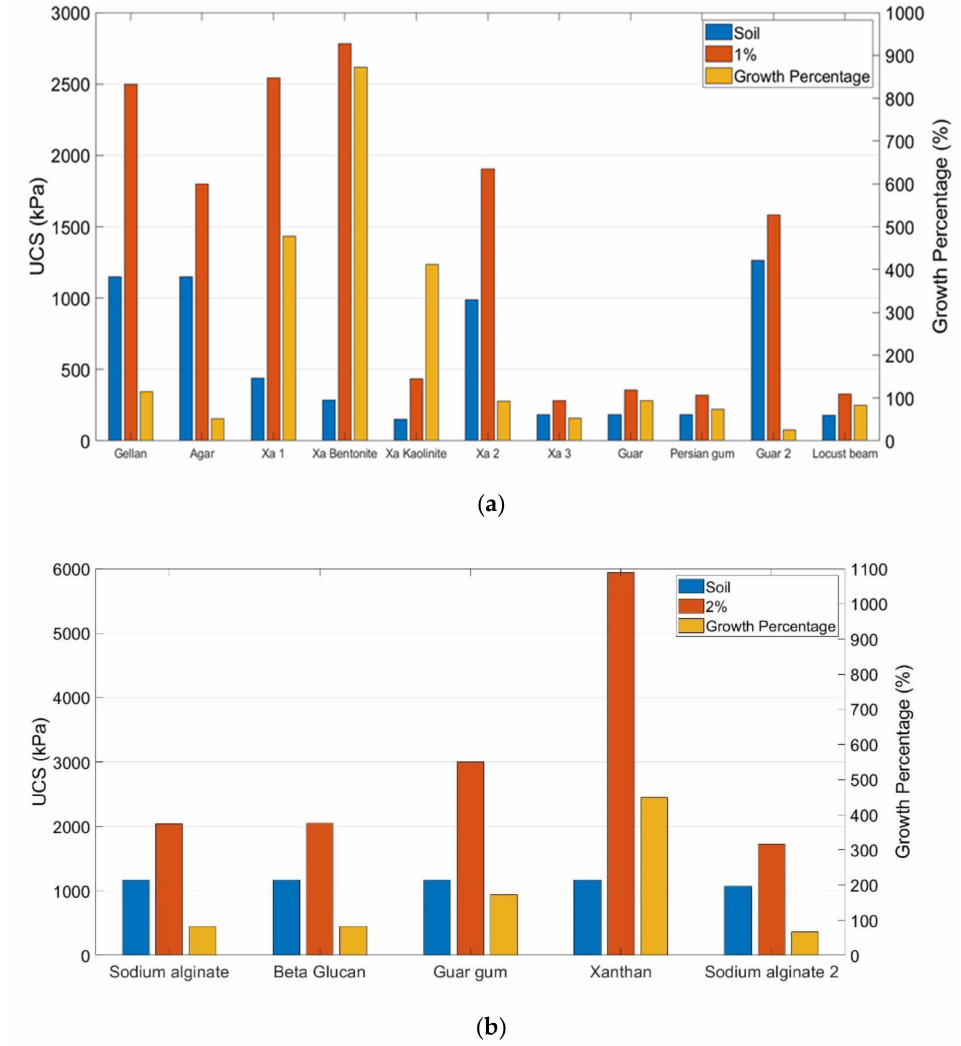
Figure 5. The effect of various biopolymers on unconfined compressive strength of fine-graded soils, ( a ) clay, ( b ) silt